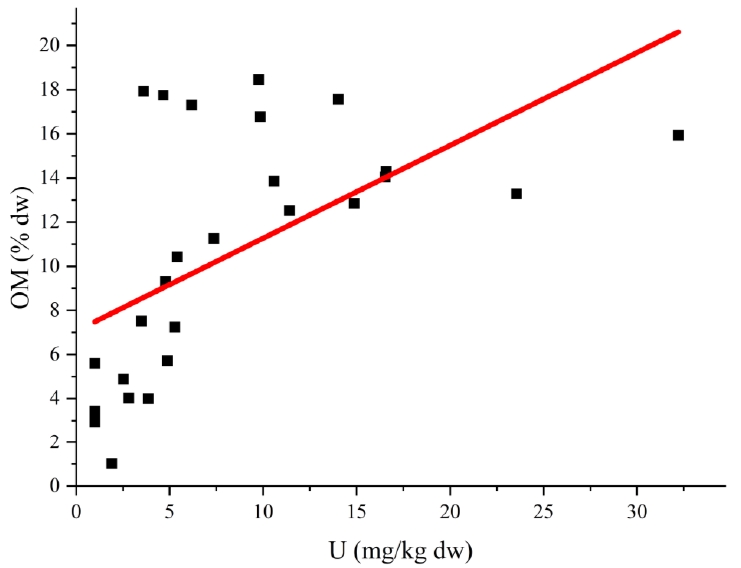
Figure 6. Positive correlation (Spearman’s Rank Order Correlation = 0.69) of OM and uranium content in sediment from sites 1 and 4.